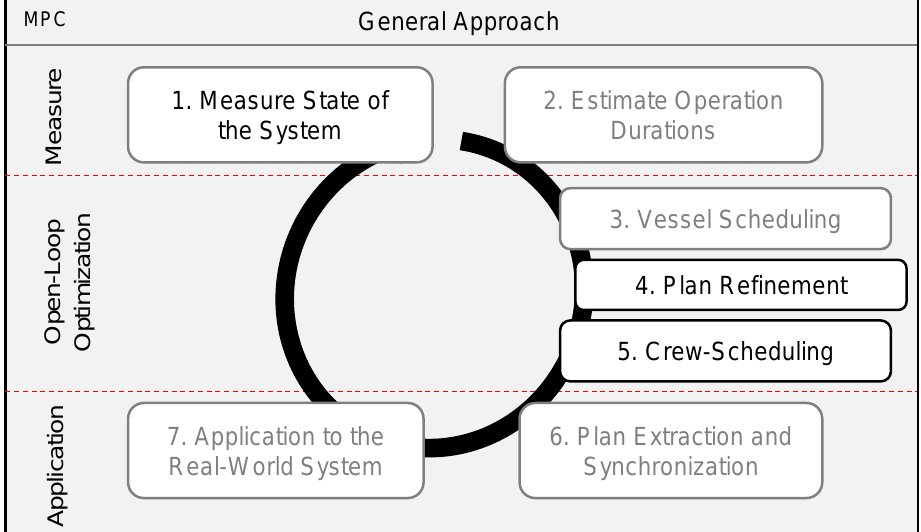
Figure 4. General Approach. Extended from Reference